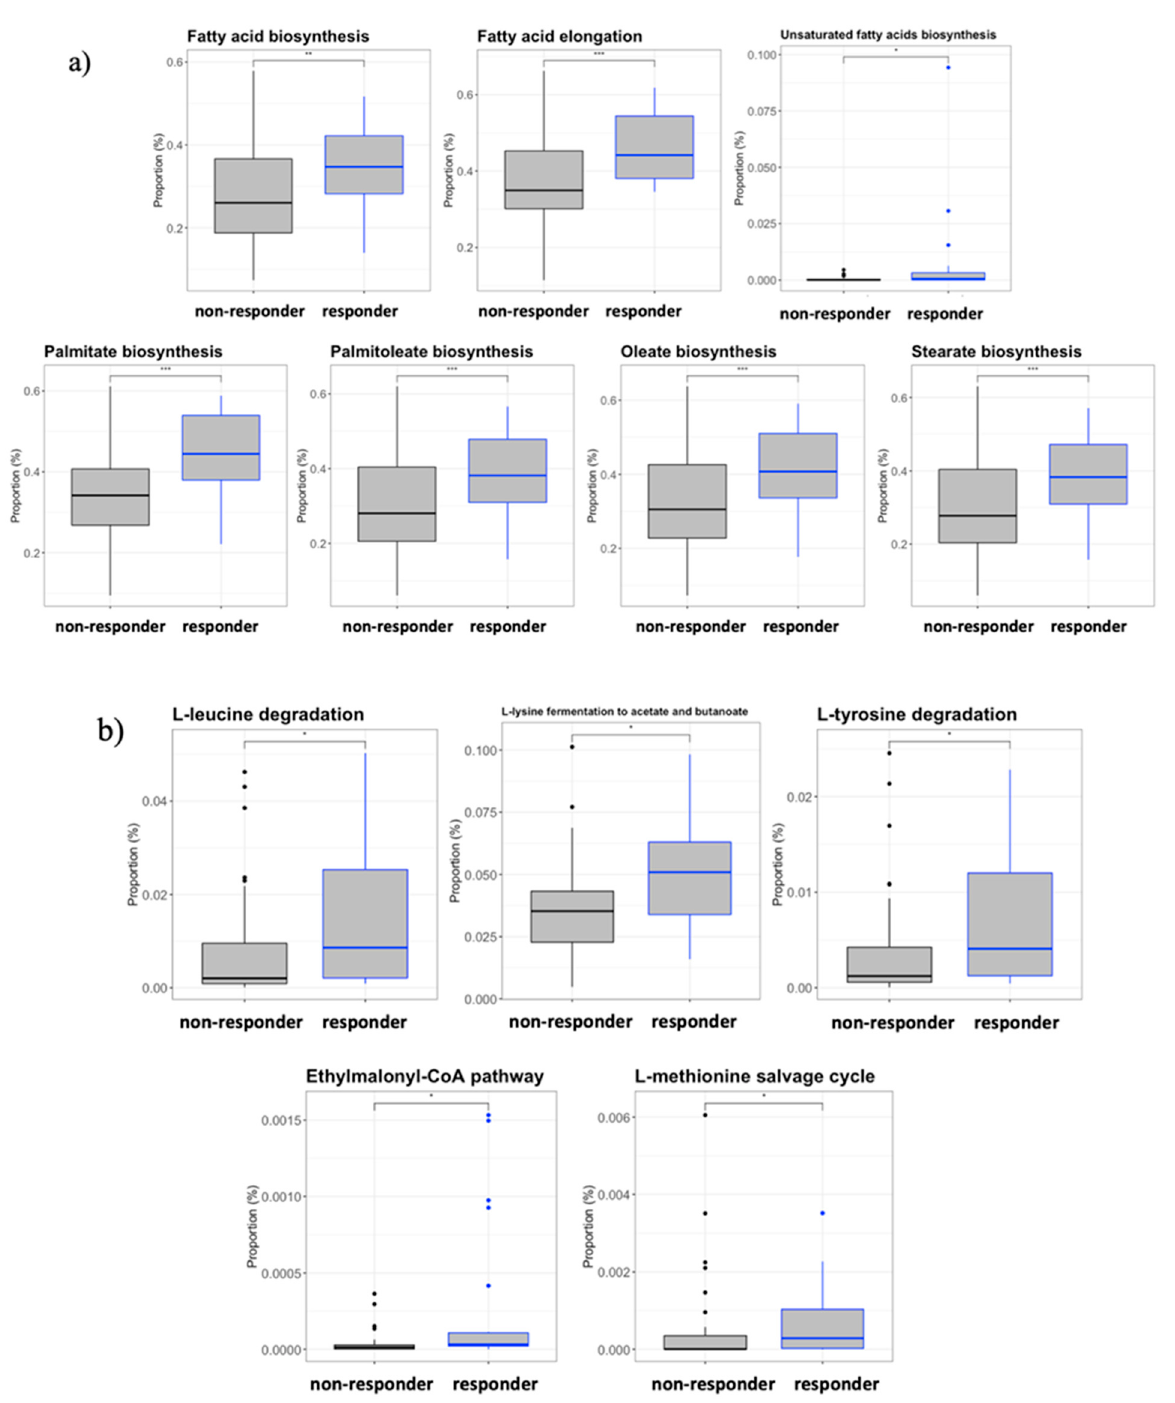
Figure 6. Inferred functional content of the gut microbiota. The metagenomic functional content of the gut microbiota was predicted by the inferred PICRUSt2 plugin from QIIME2 software. ( a ) Amino acid degradation and metabolism pathways. ( b ) Fatty acid biosynthesis and metabolism pathways. Patients were considered as responders with a delta VL set point >0.5 log10 copies/mL. For every parameter, the Wilcoxon test p -value for every comparison between the randomized groups at different time points are presented. p -Values code: p < 0.005: ***, p < 0.01: **, p ≤ 0.05: *, and p > 0.05: ns.